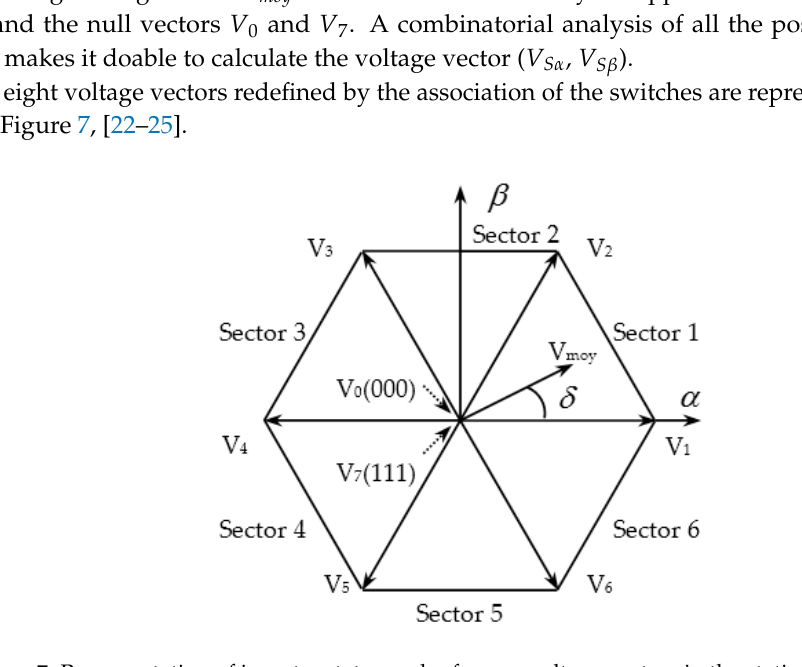
Figure 7. Representation of inverter status and reference voltage vectors in the stationary reference.